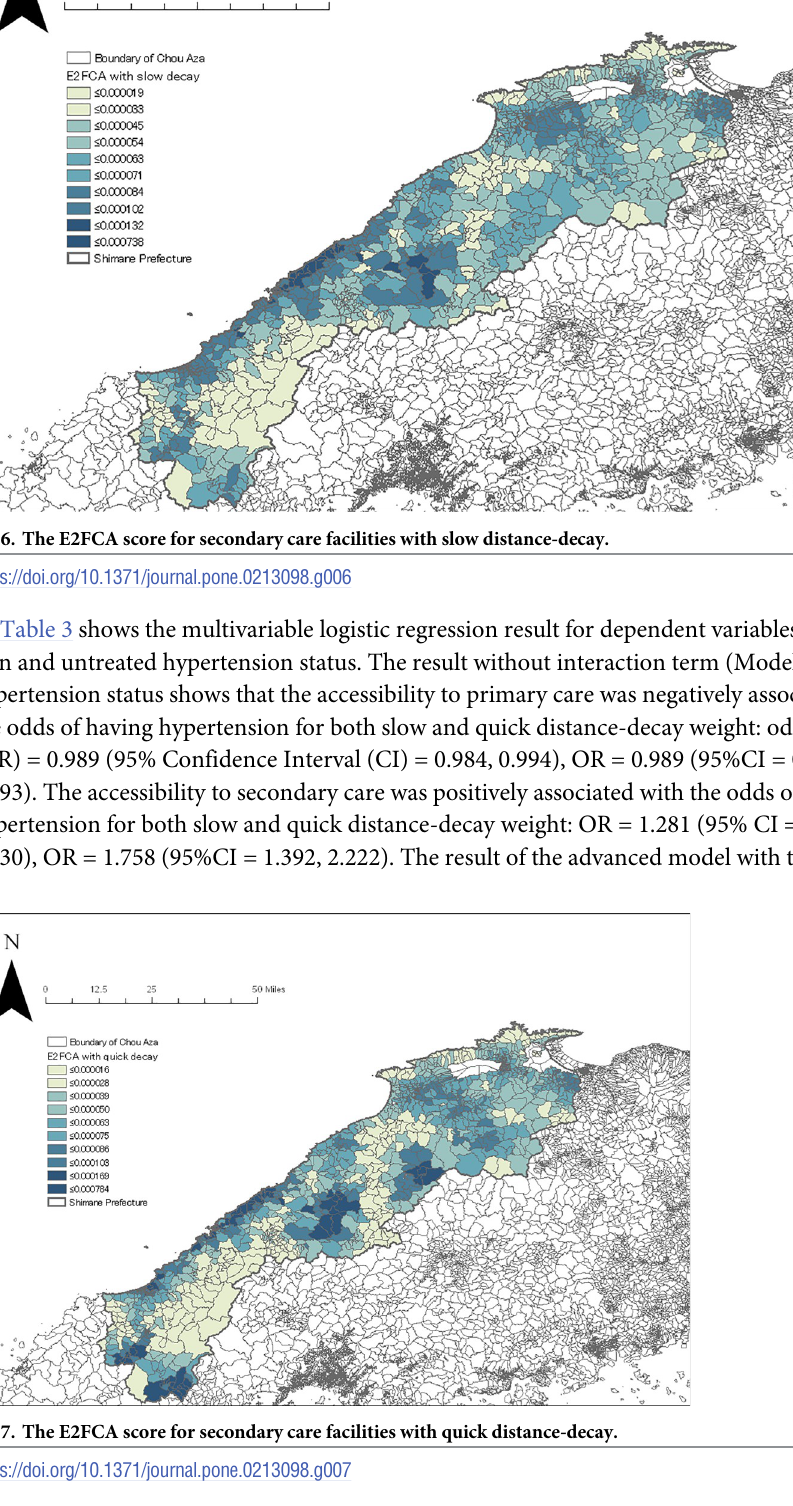
Fig 7. The E2FCA score for secondary care facilities with quick